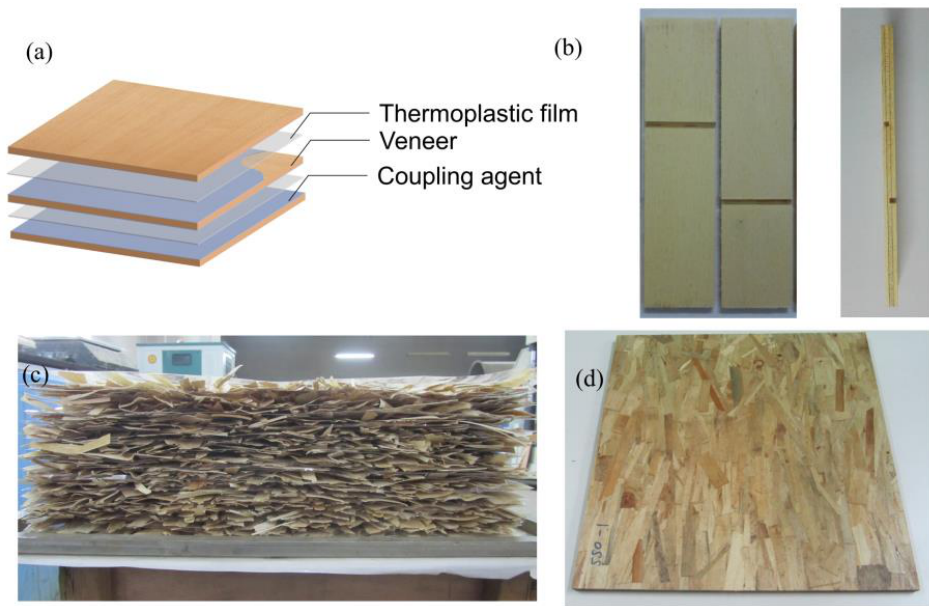
Figure 1. ( a ) Schematic diagram of the VPC; ( b ) interfacial bonding strength test samples; ( c ) forming mat of OSPC; ( d ) final OSPC product. Table 1. Experimental design for fabrication of the VPC and OSPC.